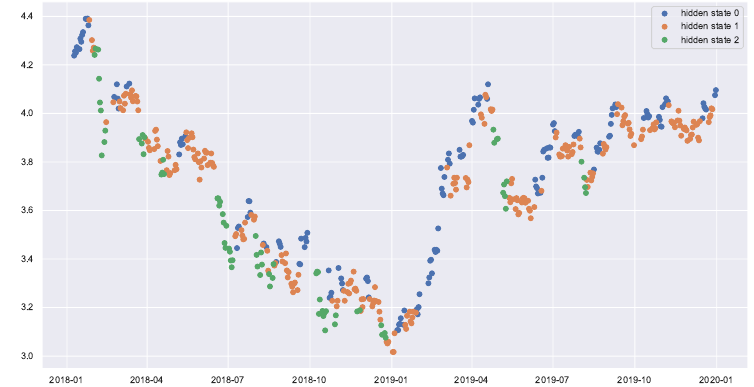
Figure 5. Index curve with hidden states.